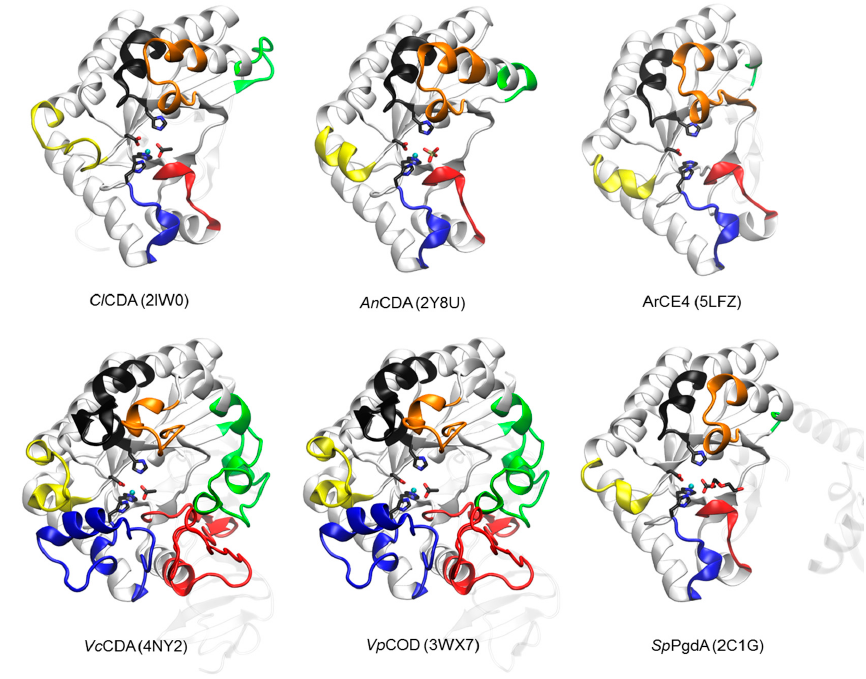
Figure 2. 3D structures of CDAs determined by X-ray crystallography. Loops 1 to 6 colored as in Figure 3. The peptidoglycan deacetylase Sp PgdA is also included for comparison (see text). In parenthesis, PDB accession codes.